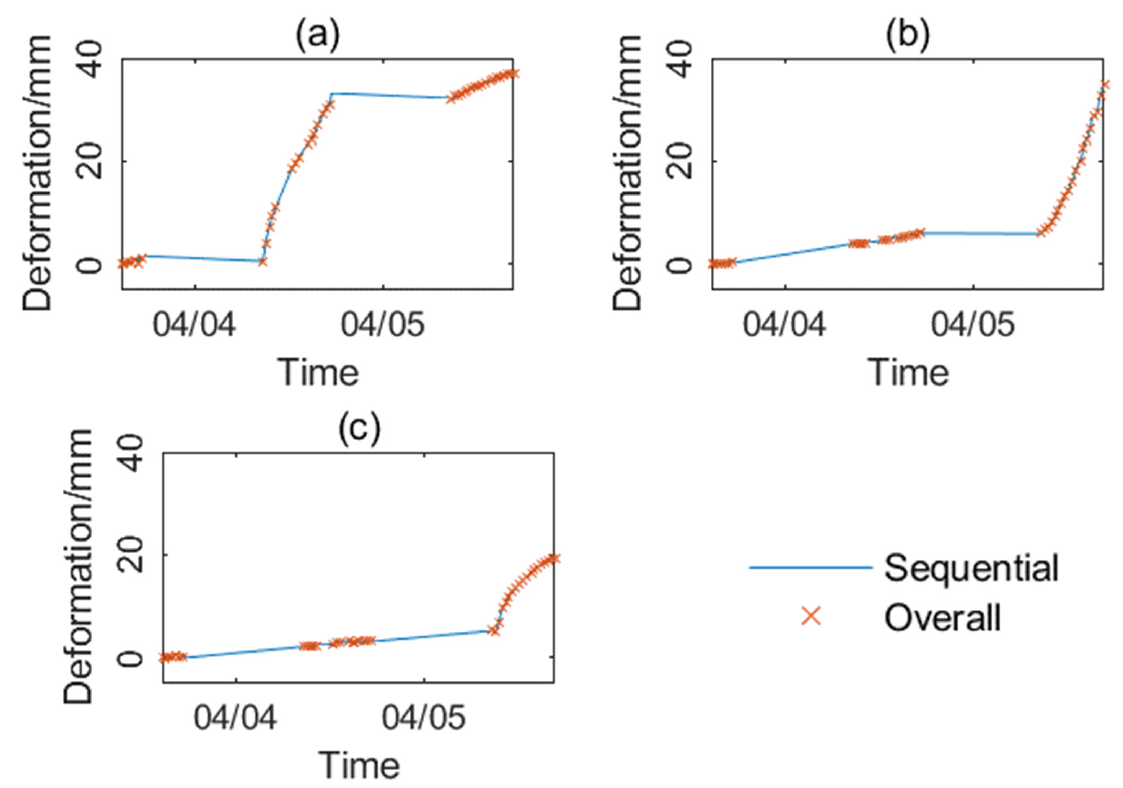
Figure 9. Cumulative deformation sequences of regions ( a – c ) obtained with sequential estimation and least squares overall estimation. Table 4. The central deformation rate of regions a, b, and c. Daily Rate (mm/day) Region